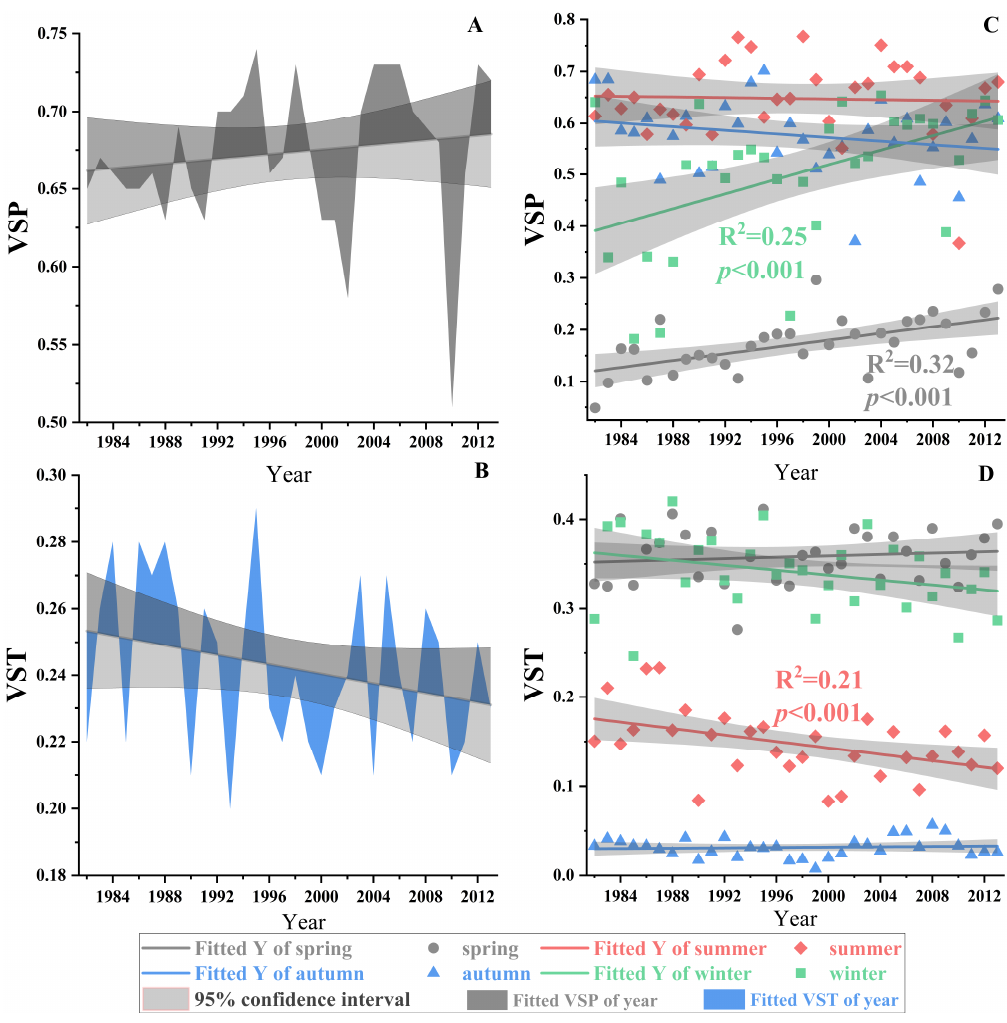
Figure 3. Temporal variability of VSP and VST by annual mean ( A , B ) and seasons ( C , D ). The gray, red, blue, and green points and lines represent spring, summer, autumn, and winter, respectively. The gray shaded portion of the fitting line represents the 95% confidence interval.